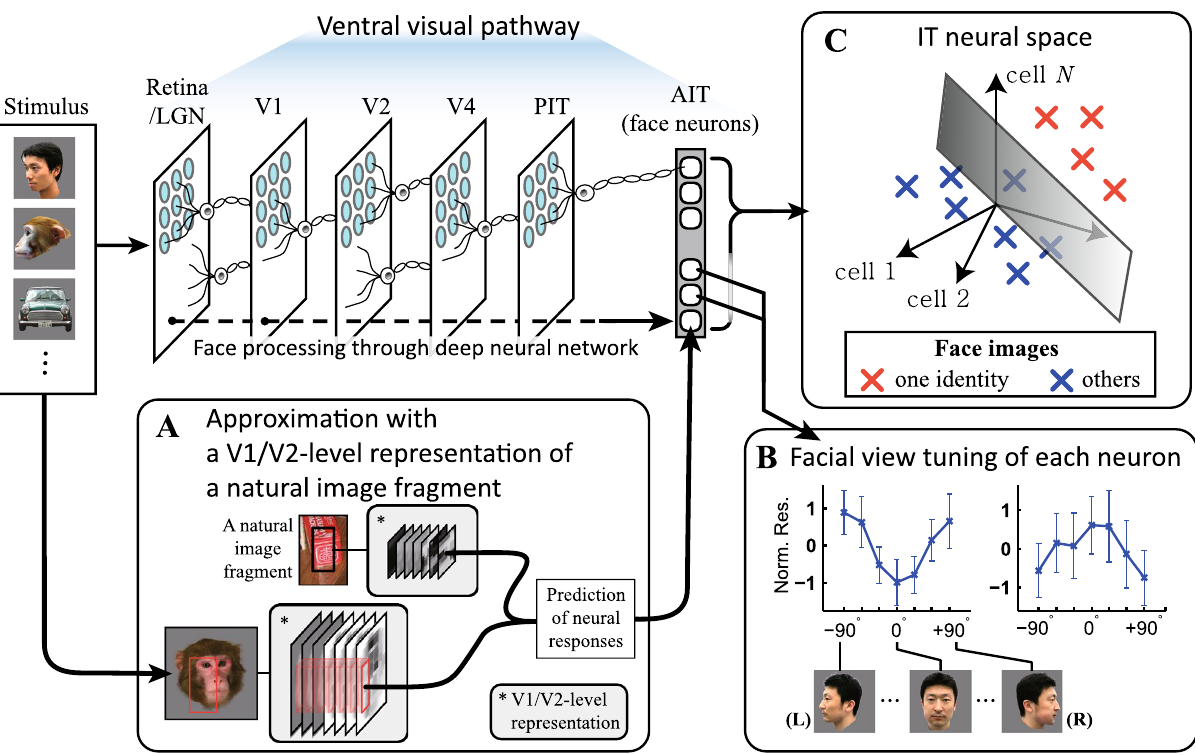
Figure 1. The view-tuned neurons in the inferior temporal cortex are regarded as the neural substrate for view- invariant face recognition, but we still do not fully understand the facial features detected by these neurons. Here, we approximated visual features encoded by these neurons as combinations of local orientations and colors (low-level representation), originated from natural image fragments. The visual features identified from the view-tuned face neurons showed that (1) IT columnar responses can be emulated by a shallow network detecting low-level representations derived from natural image fragments ( A ); (2) the resulting features